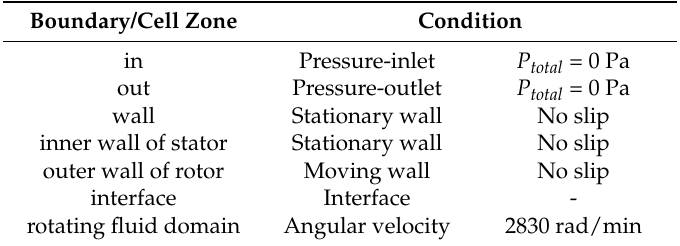
Figure 7. The section diagram of air-gap fluid field. Table 3. Boundary conditions of computational fluid dynamic (CFD) simulation.